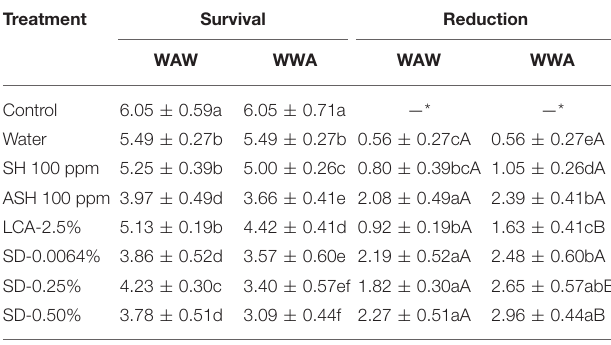
— * Indicates reduction data are not available. Mean values with different lowercase letters within a column are significantly different ( P < 0.05) . Mean values with different capital letters within a row are significantly different ( P < 0.05) .